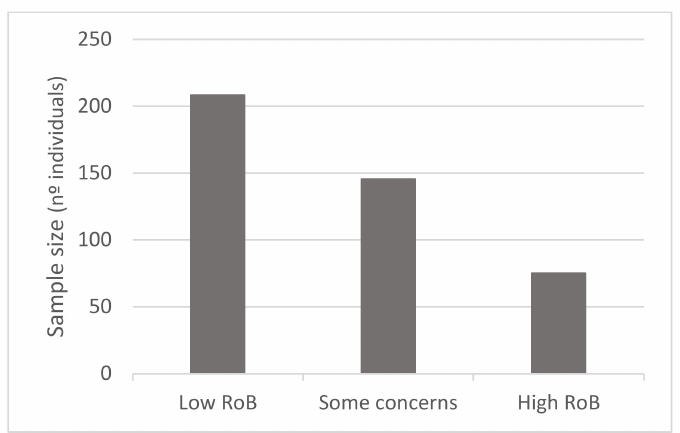
Figure 5. Mean values of the studies’ sample size according to the RoB Sample size range: 19 to 843 in low RoB, 11 to 708 in some concerns, 21 to 250 in high